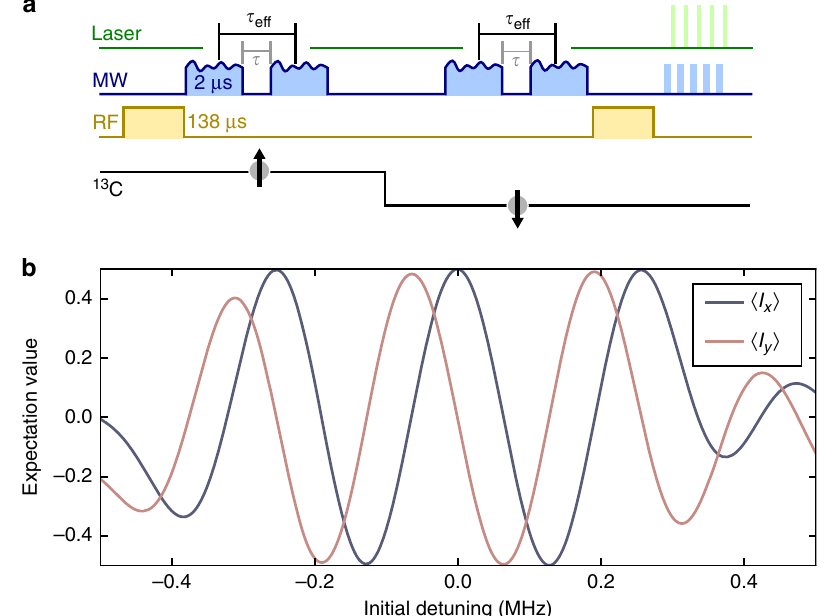
Figure 7 | Effective sensing time t eff . ( a ) Illustration of effective sensing time t eff and actual C n ROT e -gate separation t during the sensing intervals of the correlation spectroscopy sequence (cf. Fig. 6) due to finite pulse length. A 13 C sample spin (lower (black) line and arrow) adds an initial detuning to the sensor spin in the first t eff , is flipped during T c and then adds the negative of the initial detuning to the sensor spin during the second t eff . ( b ) Simulated phase of the memory spin after the second phase accumulation period as displayed in a for t ¼ 0 depending on the initial detuning created by the sample spin. The phase is depicted as x and y quadratures of the memory spin, I x h i and I y (cid:5) (cid:6) , respectively. We attribute this phase to an accumulation time t 0 ¼ t eff (cid:3) t during the C n ROT e -gate duration. Over a spectral range of approximately 0.5MHz the expectation values show almost full contrast.